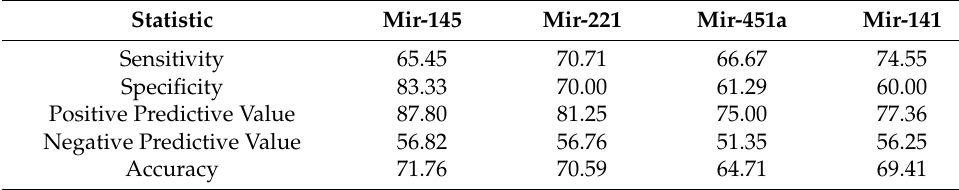
Table 1. Parameters of diagnostic significance for the selected